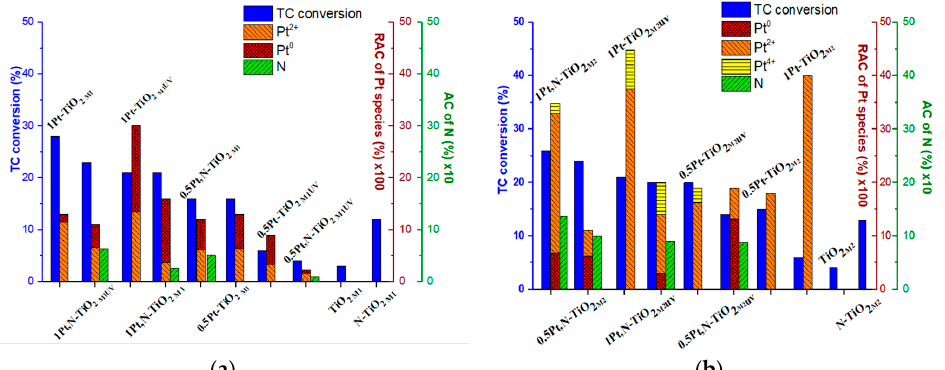
Figure 10. Photocatalytic activity of Pt-doped and Pt,N co-doped TiO 2 , TiO 2 and N-TiO 2 films obtained by ( a ) Method 1 and ( b ) Method 2 vs. relative atomic content (RAC) of Pt 0 and Pt ions(100) vs. atomic content (AC) of N (10).